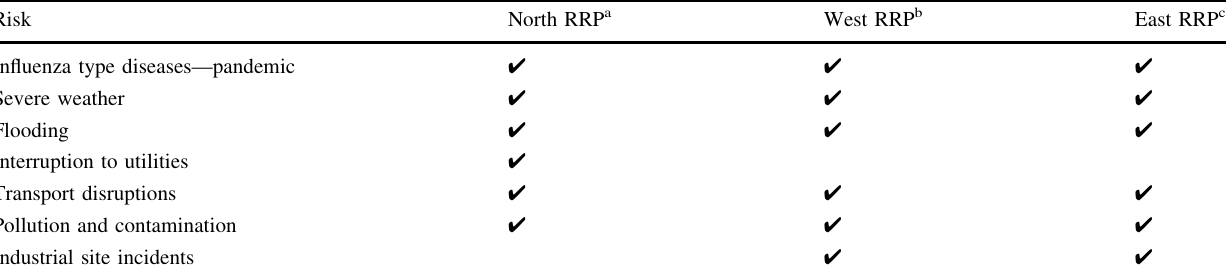
Table 3 The nature of major hazards in Scottish Regional Resilience Partnerships. Source : Adapted from the North, West, and East of Scotland Community Risk Registers